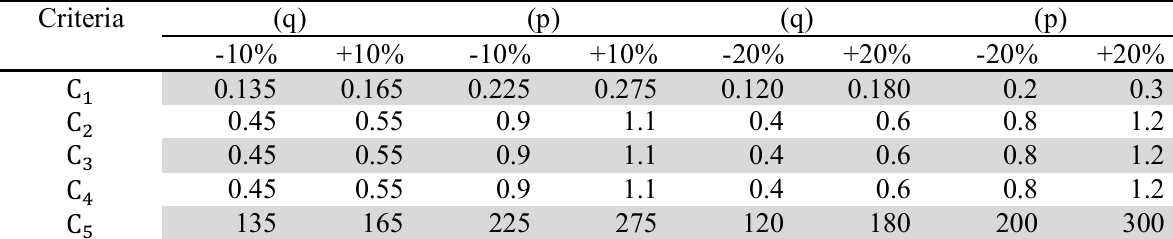
Sensitivity analysis: 10% and 20% change in thresholds p and